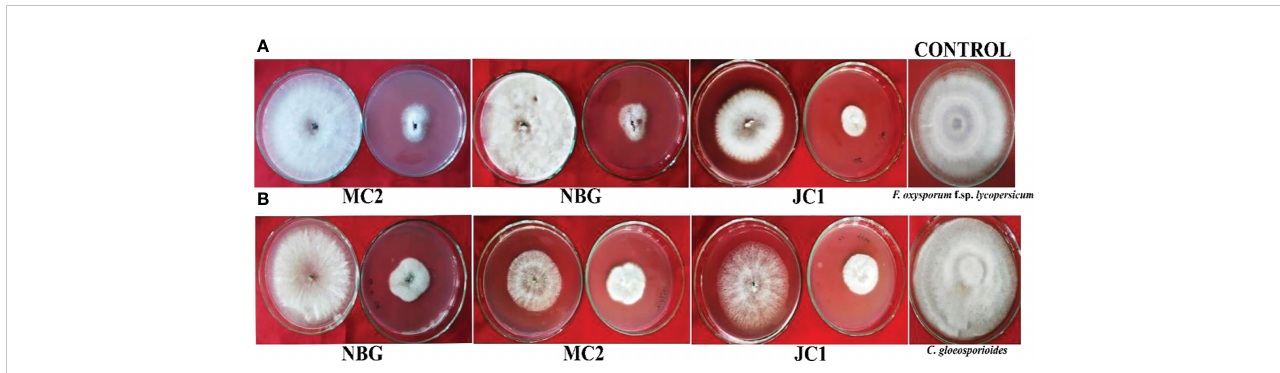
FIGURE 6 Dual culture assay for bioactivity of volatile organic compounds of the rhizospheric isolates on plant pathogens: (A) Fusarium oxysporum f.sp. lycopersicum , (B) Colletotrichum gleoesporioides. The bioagent culture was on the bottom and the test pathogen culture was on the lid facing downwards. Both the bioagent and pathogen were grown on PDA and exposed to each other for 7